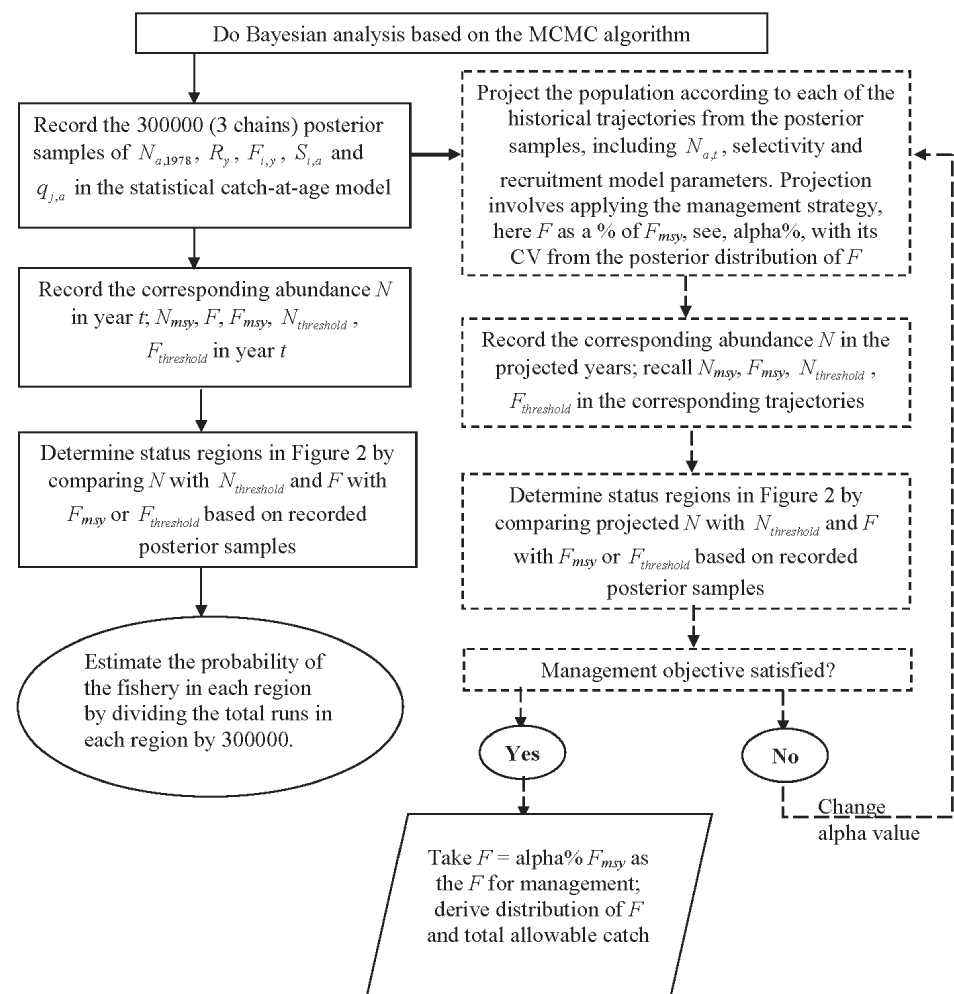
Fig . 3. – Uncertainty estimation algorithm for control rules using a Bayesian method, with 300000 posterior samples to estimate the fishery status